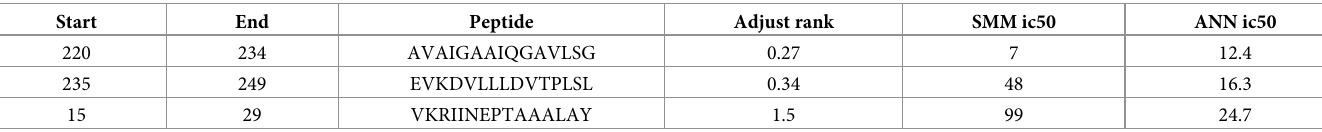
Table 4. Prediction of conserved peptides of antigen for binding to MHC class II of T-cell epitopes. Start